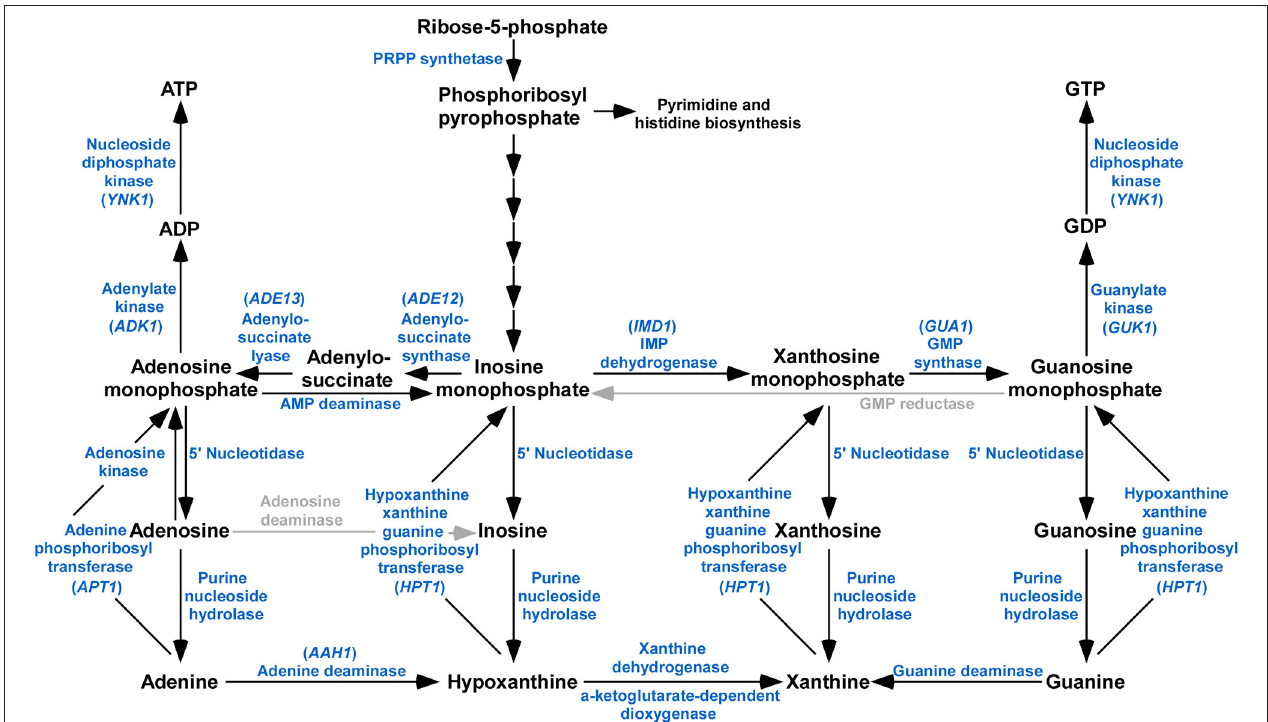
FIGURE 1 | Schematic representation of purine metabolism pathway identified in M. oryzae . BLASTp analysis using S. cerevisiae and C. neoformans orthologs reveals that majority of the components of the purine biosynthetic pathway are present in the genome of M. oryzae . Enzymes or activities missing are grayed.